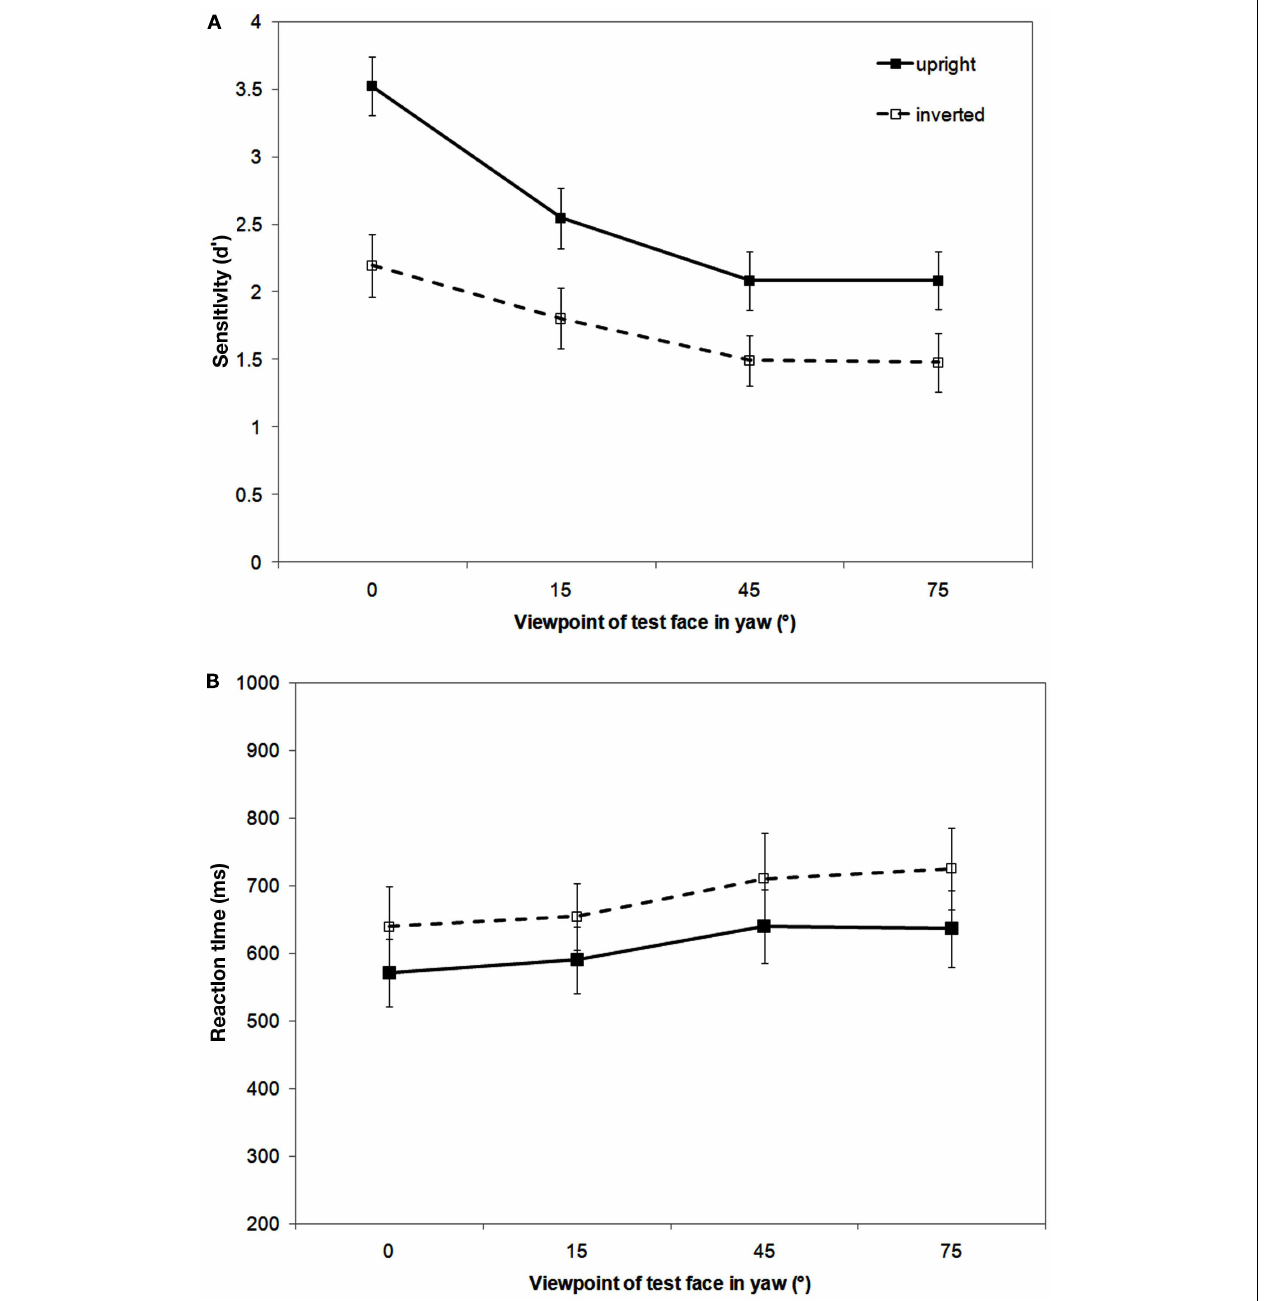
FIGURE 3 | Results of the sequential matching task showing mean recognition sensitivity [ d (cid:48) (A)] and reaction time [ms (B)] as a function of yaw viewpoint and orientation (upright and inverted). Error bars represent 1